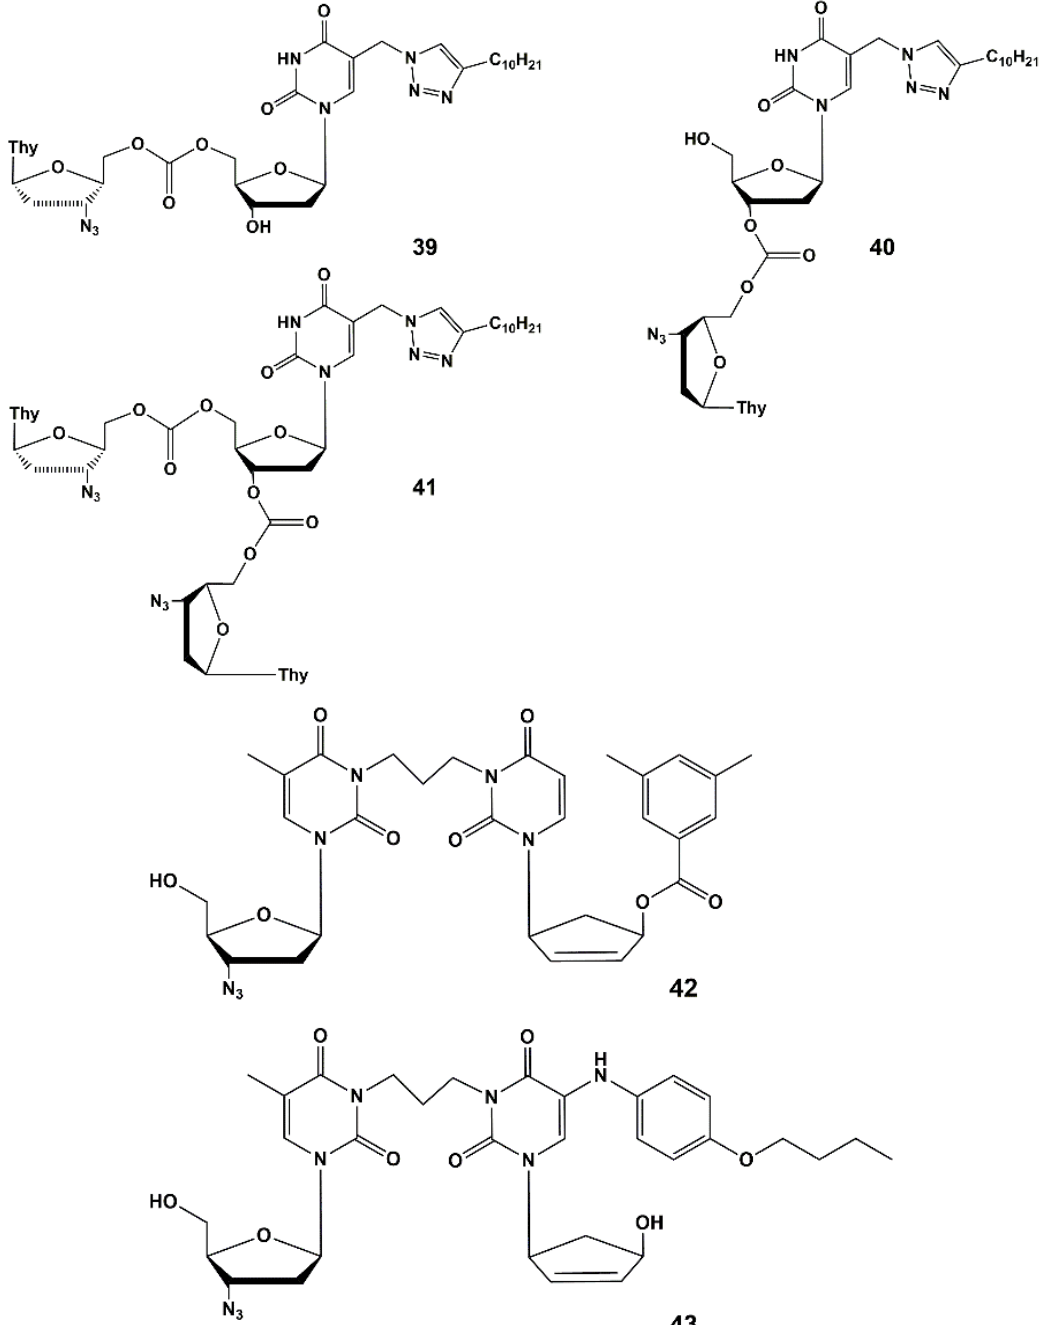
Figure 11. Heterodimers of AZT and 5-(4-decyl-1,2,3-triazol-1-yl-methyl)- 2 ′ -deoxyuridine ( 39 – 41 ) and the 5 (cid:48) -norcarbocyclic analogues of 2 (cid:48) ,3 (cid:48) -dideoxy-2 (cid:48) ,3 (cid:48) -didehydrouridine ( 42 – 43